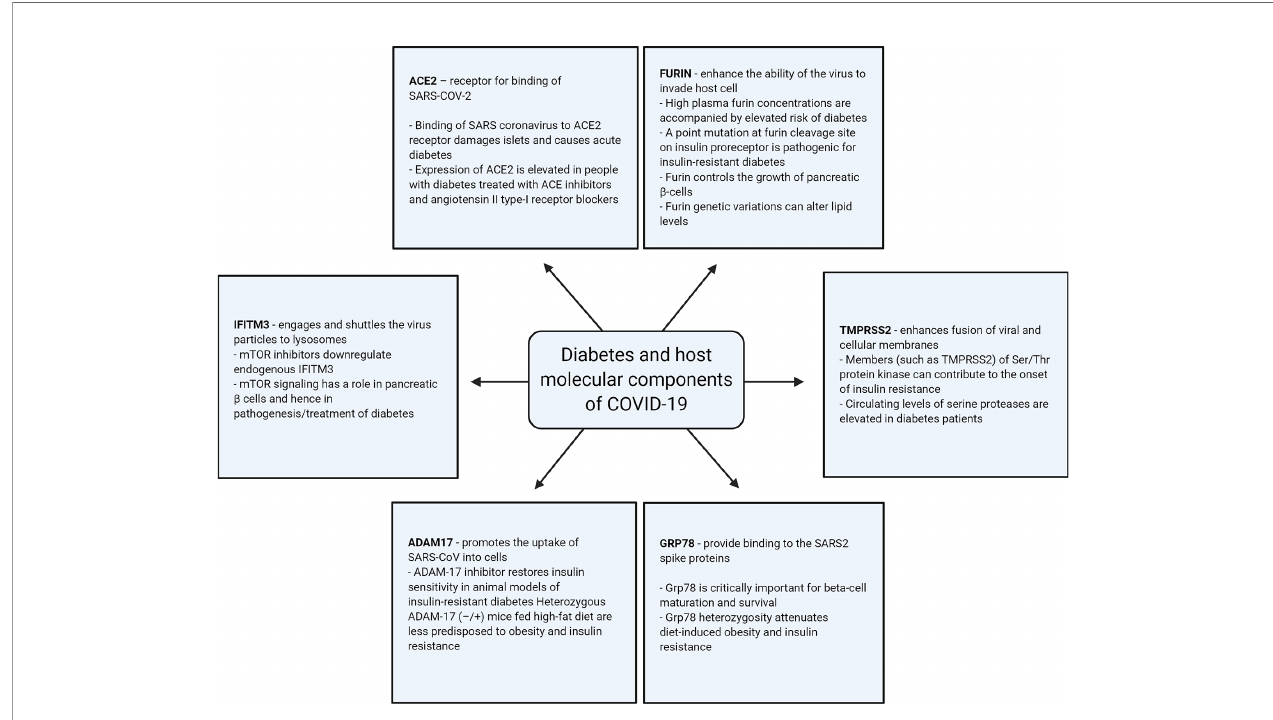
FIGURE 2 | Illustration of association of the different host-cellular proteins involved in SARS-COV-2 infection with